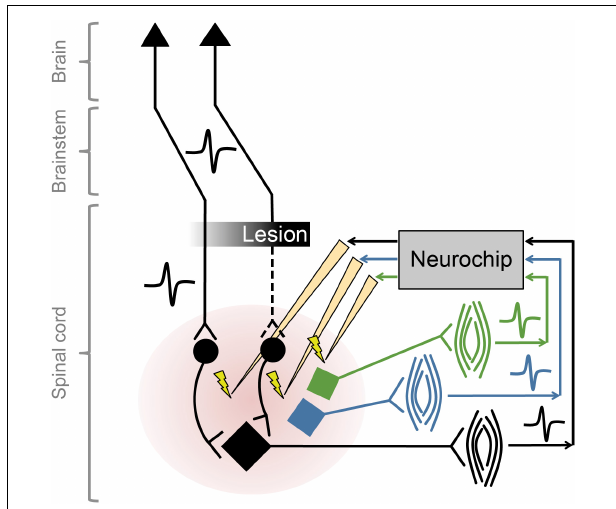
FIGURE 7 | Multiple simultaneous closed-loop stimulation with NC3. As shown for the black circuit, descending pathways are partially lesioned by spinal cord injury. The paretic black muscle generates motor unit potentials that are converted to stimuli delivered to spinal neurons in the pathways to the black motoneuron (at intensities subthreshold for evoking movement). Comparable circuitry pertains to the blue and green motoneurons.